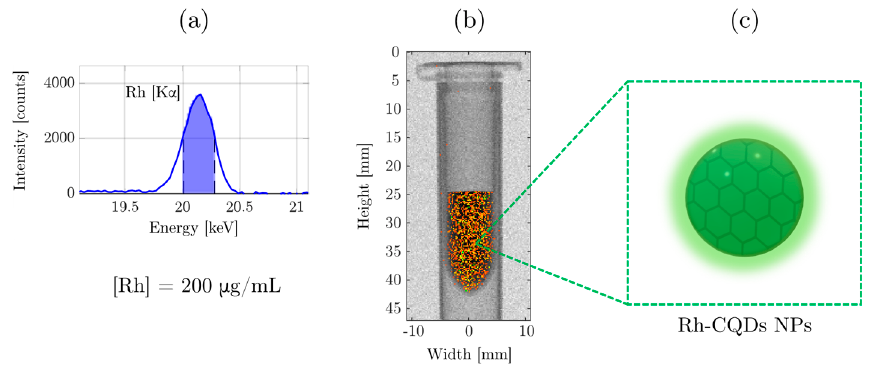
Figure 6. X-ray Fluorescence (XRF) experiment on Rh-CQDs NPs at 200 µ g/mL. XRF spectrum recorded for 3 min at the central position of the vial ( a ); projection image of the vial with absorption and XRF signals ( b ); schematic representation of Rh-QDs NPs, contained in the vial ( c ).